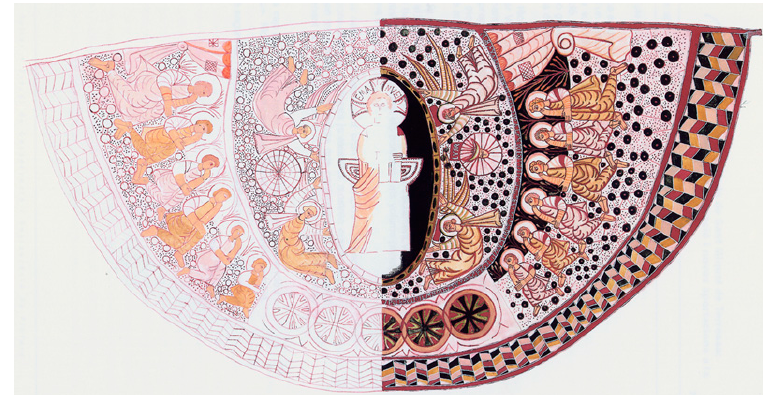
Arts 2019 , 8 , x FOR PEER REVIEW Figure 8. Drawing of the wall paintings of Sant Miquel (Terrassa). © ARCOR (with kind Figure 8. Drawing of the wall paintings of Sant Miquel (Terrassa). © ARCOR (with kind permission). Figure 8. Drawing of the wall paintings of Sant Miquel (Terrassa). © ARCOR (with kind permission). permission).